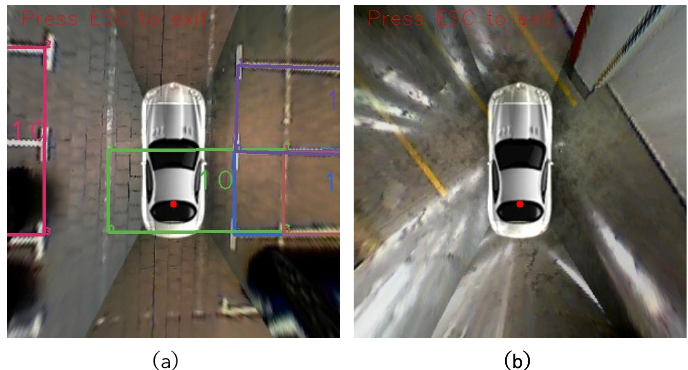
Figure 12. Typical failure modes. In ( a ), the left rose red one is caused by miss detection of one L-shaped structure which results in the detecting result as a parallel parking space. The right two error results are caused by disturbance lines incorrectly appearing on the ground. ( b ) is a situation that our proposed method currently does not support.